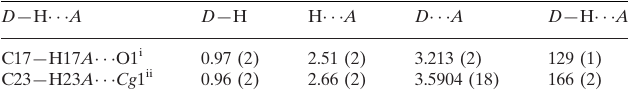
Hydrogen-bond geometry (A˚ , (cid:2) ). Cg 1 is the centroid of the C13–C18 benzene